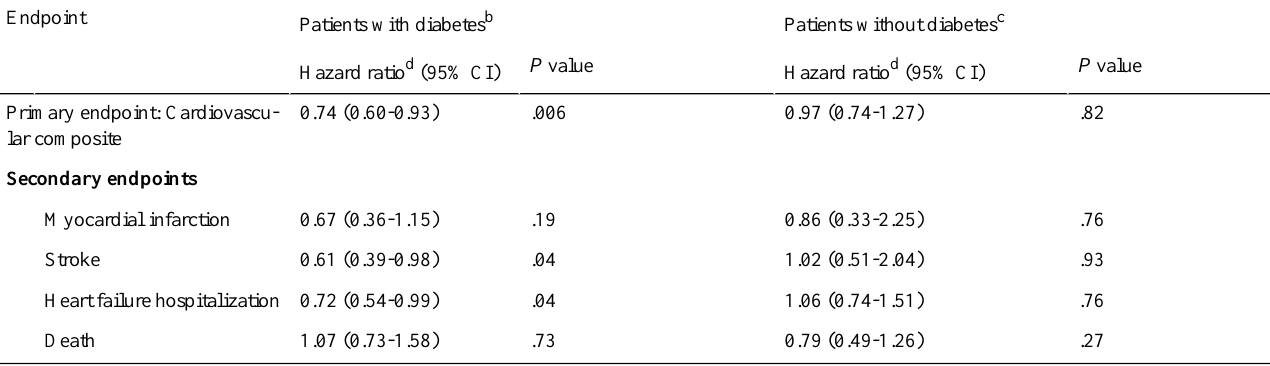
Table 3. Subgroup analysis according to diabetes status in comparing the endpoints between matched cohort 1 and cohort 2. a